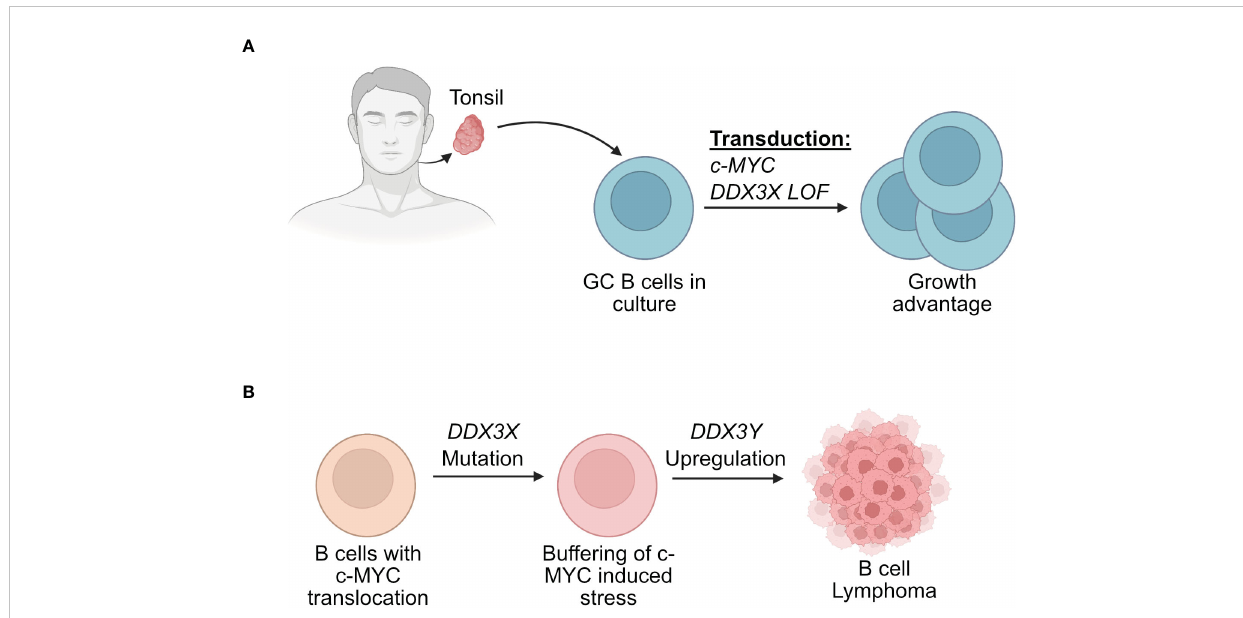
FIGURE 5 Effect of DDX3X mutations in human B cells. (A) Human GC B cells extracted from tonsils have a growth advantage when they are transduced with vectors driving the expression of c-MYC and mutated form of DDX3X. (B) Human B cells that acquire a c-MYC translocation and a loss of function of DDX3X can overcome c-MYC induced proteotoxic stress but require DDX3Y upregulation for effective